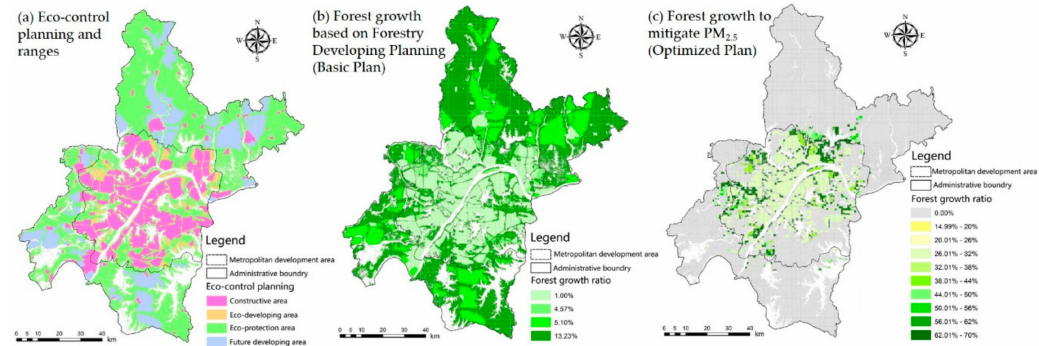
Figure 3. ( a ) The Wuhan eco-control red line range, ( b ) the basic plan based on forestry developing planning, and ( c ) the optimized plan to mitigate PM 2.5